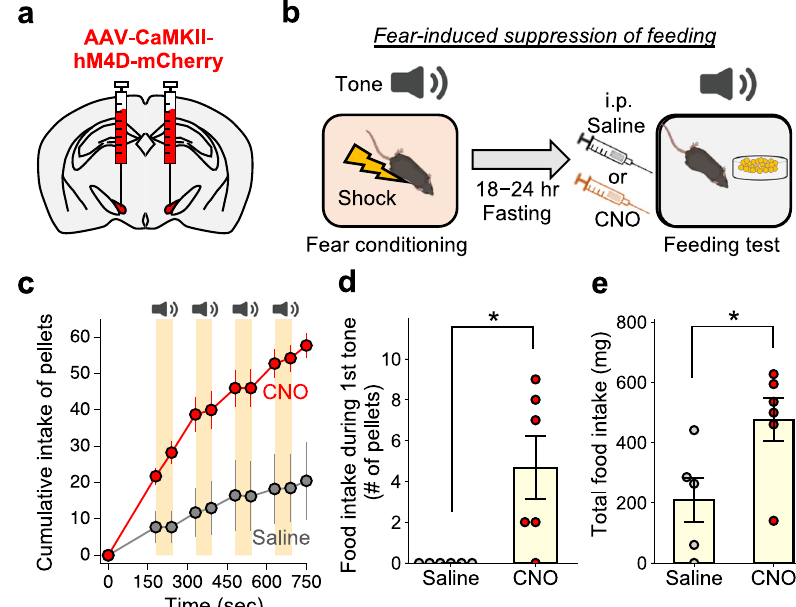
Fig. 4 | Inhibition of PSTN neurons attenuates fear-induced suppression of feeding. a Schematic of microinjection into the PSTN of the C57BL/6J mouse. b Schematic illustration of fear-induced suppression of feeding. c Cumulative numberofsmallfoodpelletsingestedbymiceduringthefeedingtest(Saline, n =4; CNO, n =4). The number of pellets was measured before and after each tone